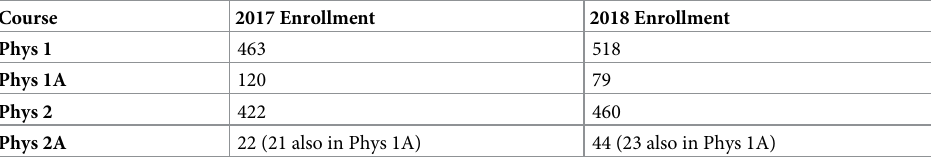
Table 1. Enrollment numbers for Phys 1(A) and Phys